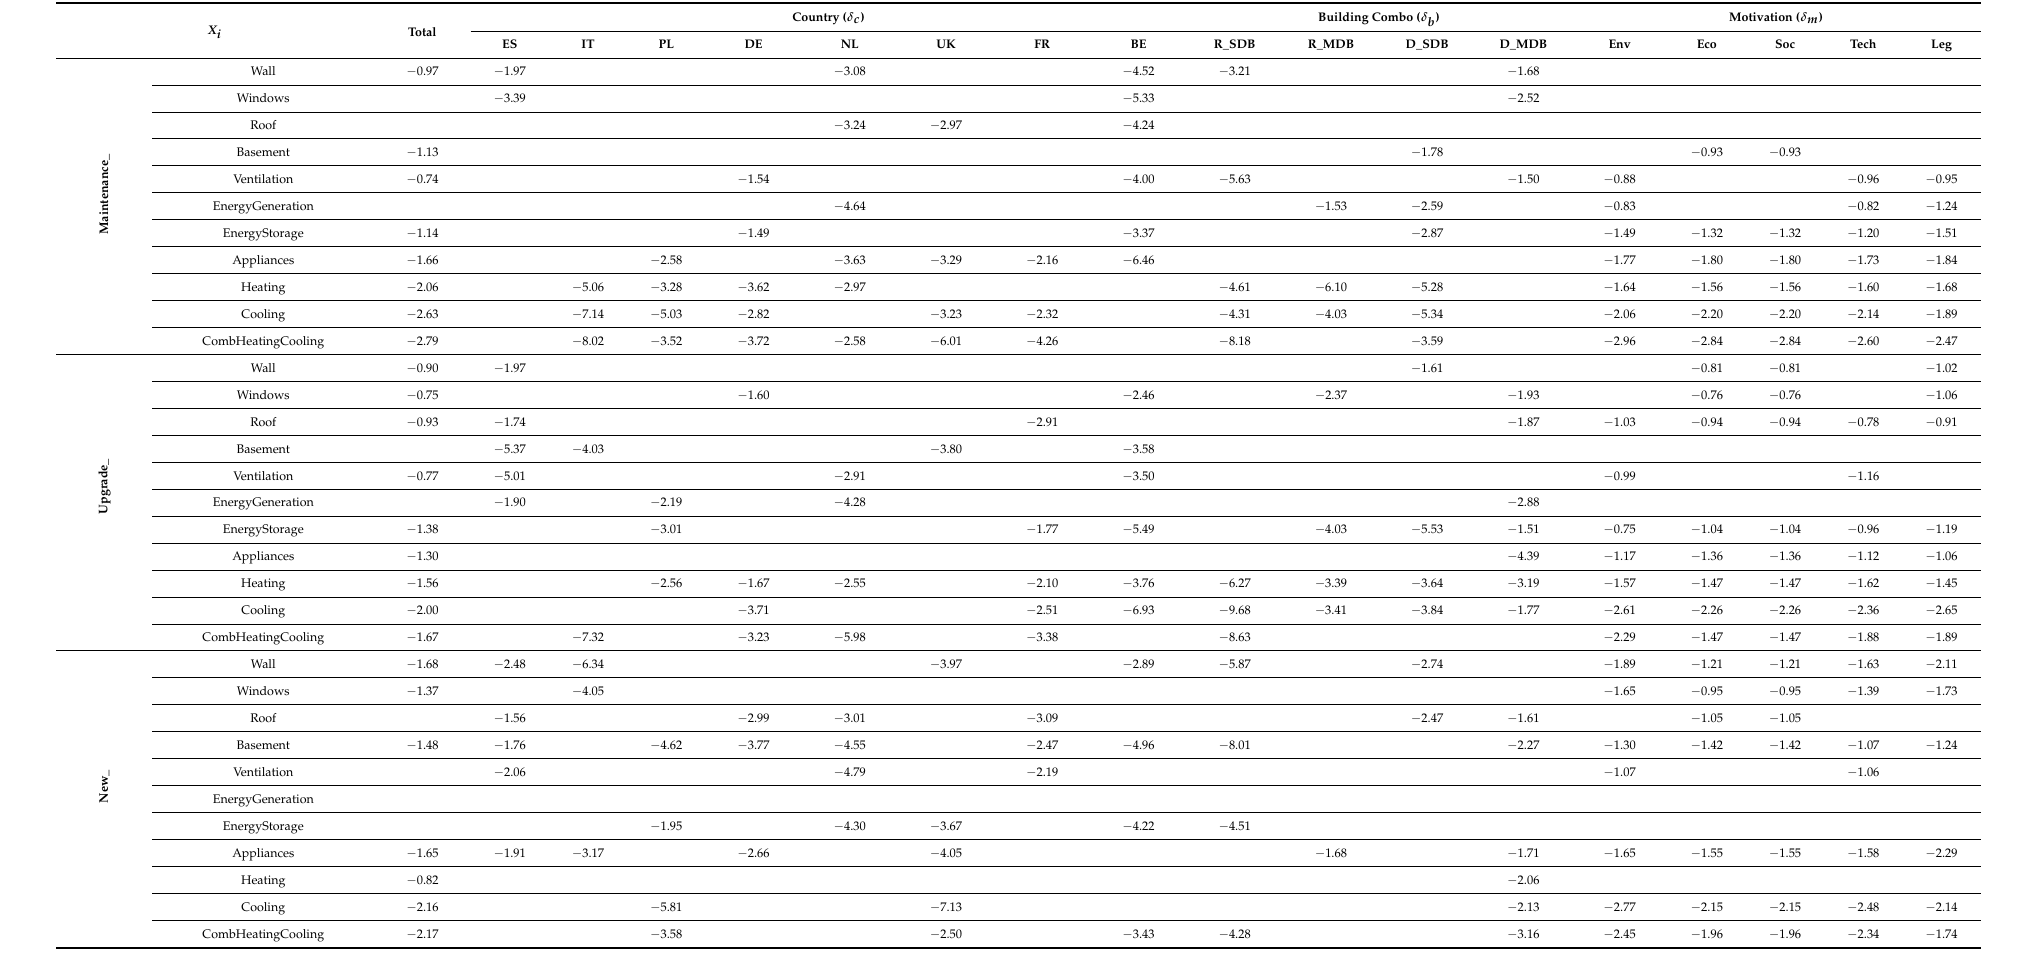
Table 8. Logit model results: main effects (Equations